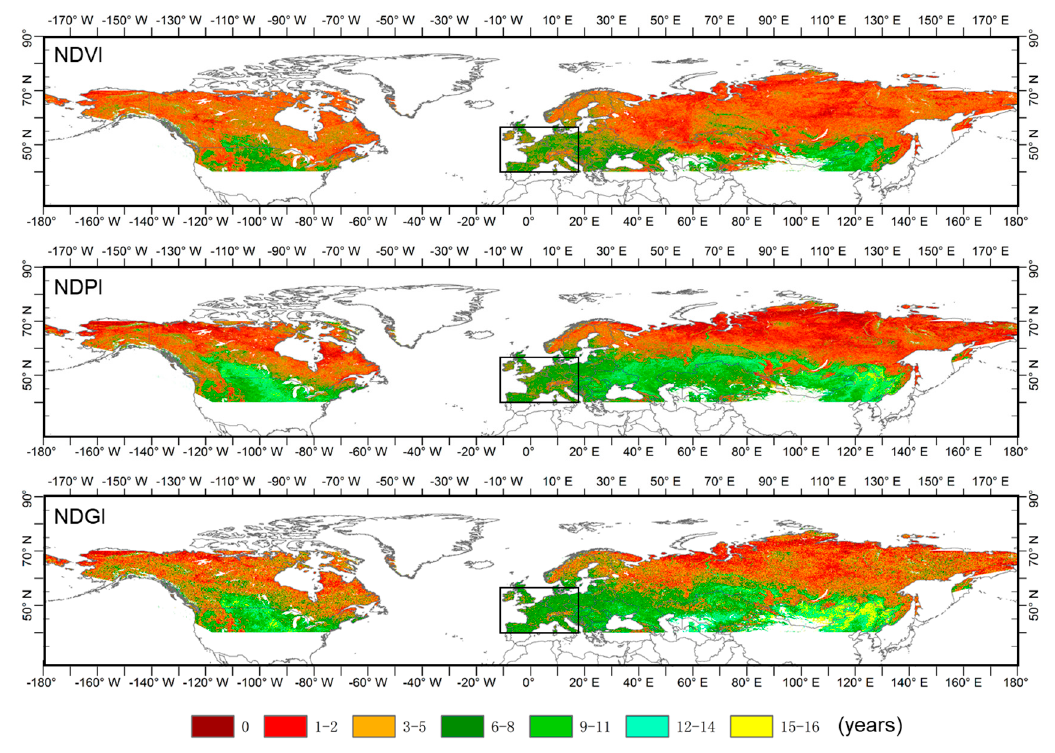
Figure 10. The number of years with GUD uncertainty smaller than three days during 2001–2016 over the north of 40 ° N.